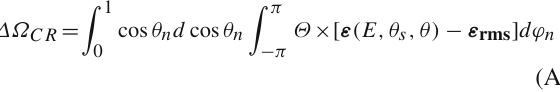
for the case that the shower axis is parallel to the satellite orbit